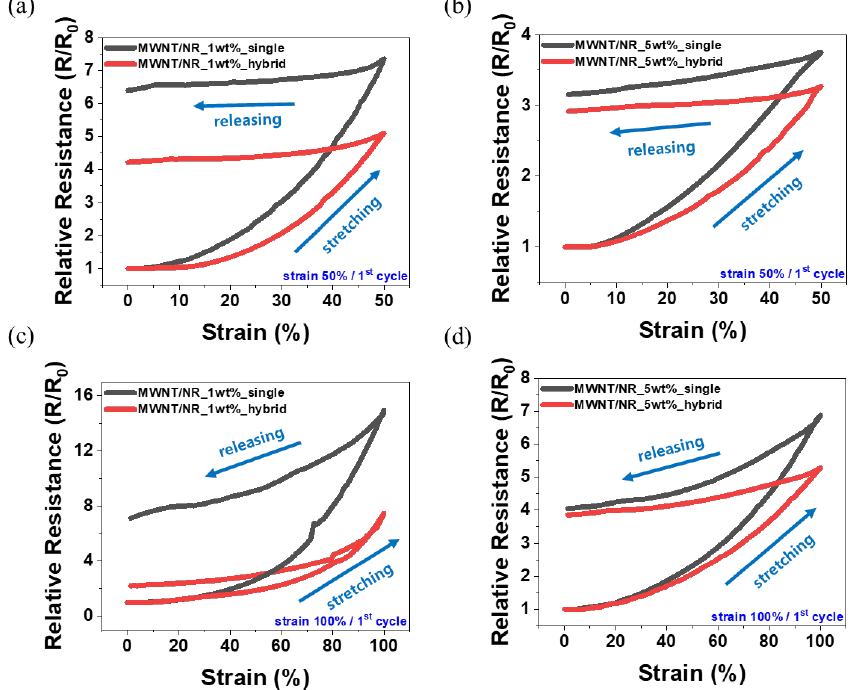
Figure 5. Hysteresis curve of 50% strain range for ( a ) 1 wt.% single composite and ( b ) 5 wt.% hybrid composite. Hysteresis curve of 100% strain range for ( c ) 1 wt.% single composite and ( d ) 5 wt.% hybrid composite. Table 2. Degree of plastic deformation of the MWNT/NR composite, based on each concentration and structural formation.